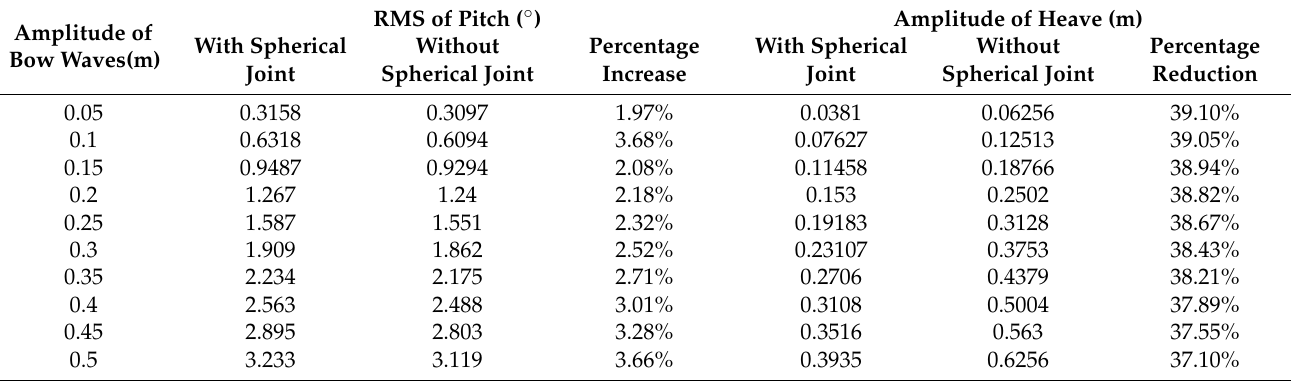
Table 8. Pitch and heave response with and without spherical